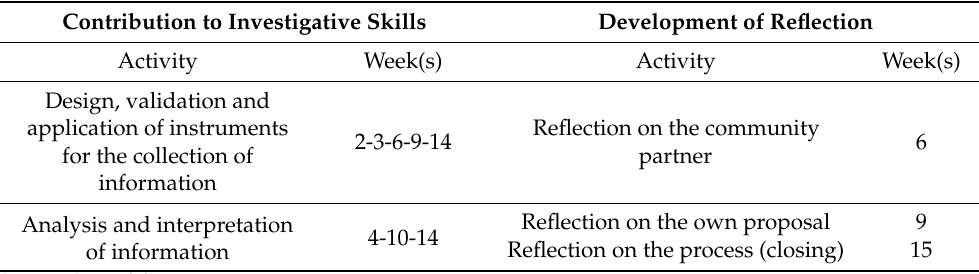
Table 1. Development of skills by